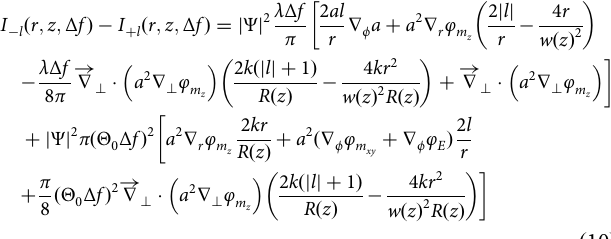
Figure 2b, c show images of a uniformly-magnetized nanoparticle with a 20 nm radius, obtained using Eq. (8) and an EVB with OAM = 80. The simulated images shown in Fig. 2b.ii, c.ii are both sums of 50 different images with the distance from the beam waist to the sample plane ranging from 200 nm to 100 um . The objective lens defocus is constant for all images that contribute to the series, in Fig. 2 b.ii, c.ii the OML defocus is 0 nm and 500 nm, respectively. Notably, in Fig. 2b.ii, c.ii there is decreased intensity at the corners of our simulations. This apparent four-fold symmetry is due to the fi nite size of our simulations and the